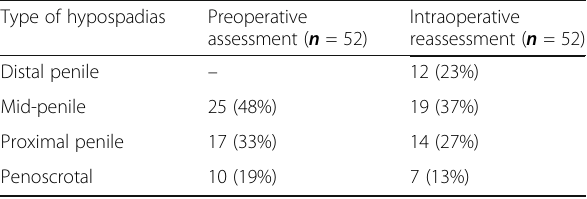
Table 2 Variation in the preoperative and intraoperative assessment of hypospadias after sequential correction Type of hypospadias